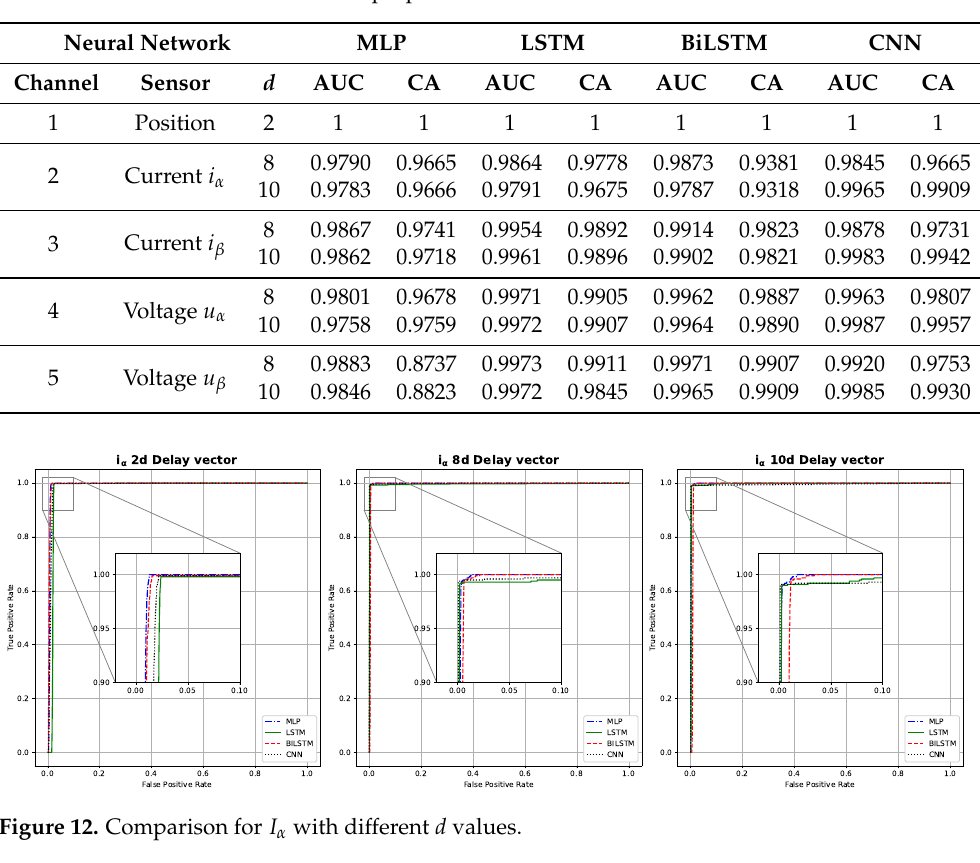
Table 4. Results obtained with all the proposed neural networks.